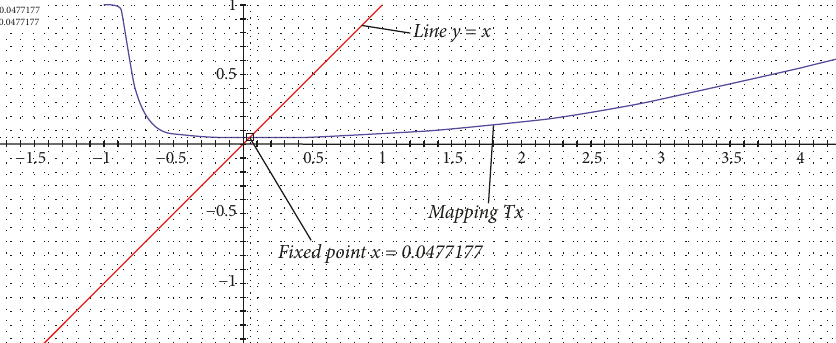
Figure 4: Fixed point of the mapping 𝑇